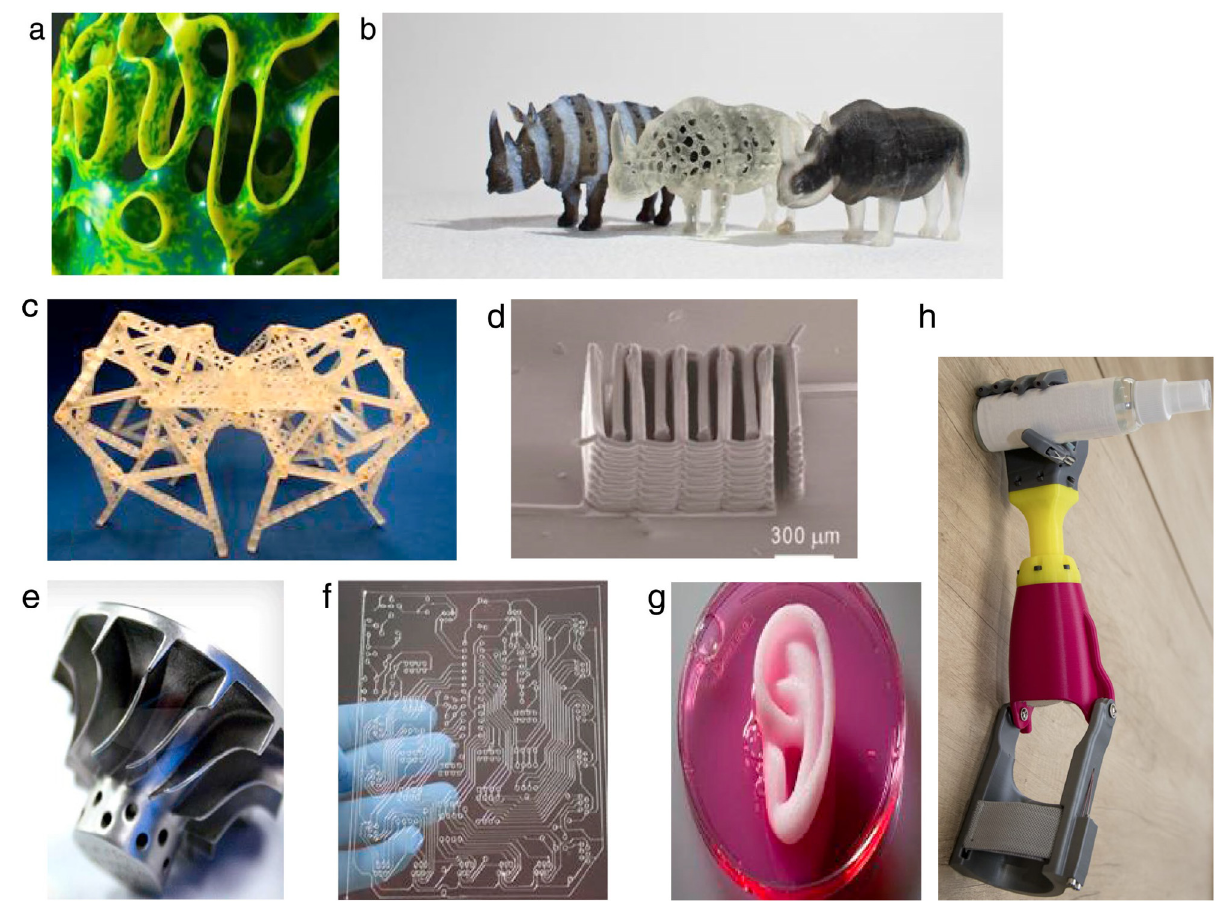
Figure 1. Examples of AM-produced parts: ( a ) artistic shapes inspired by nature, ( b ) three rhinos, printed using OpenFab, ( c ) Theo Jansen locomotive mechanism, ( d ) 3D printable lithium-ion rechargeable battery, ( e ) metallic turbine, ( f ) printed circuit board, ( g ) artificial printed ear [2], ( h ) printed prosthetic (courtesy Faculty of Technical Sciences Novi Sad) [5].